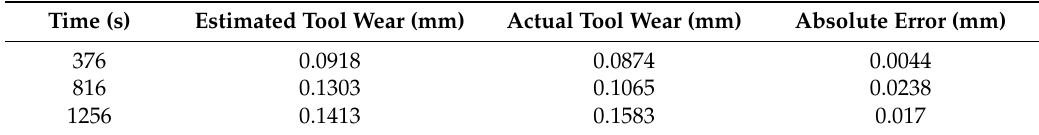
Table 4. Comparison of estimated and actual tool wear.